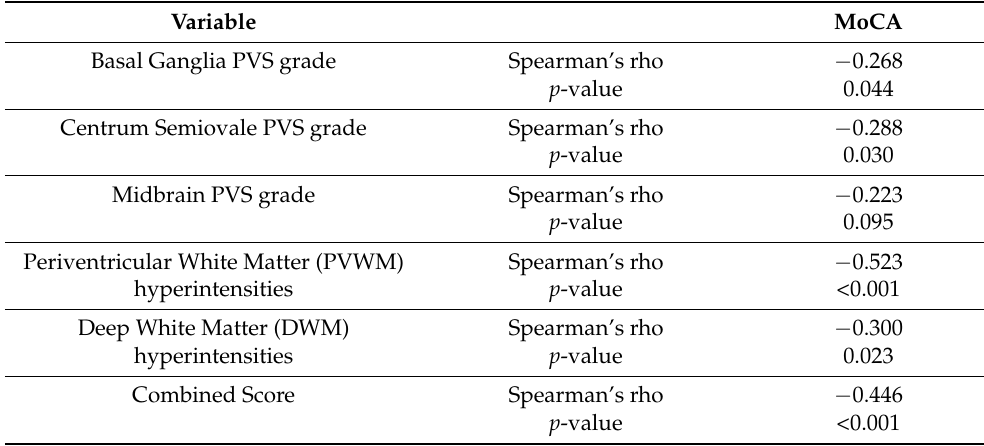
Table 10. MoCA score correlation with basal ganglia PVS grade, centrum semiovale PVS grade, midbrain PVS grade, PVWM, DWM, and combined score.